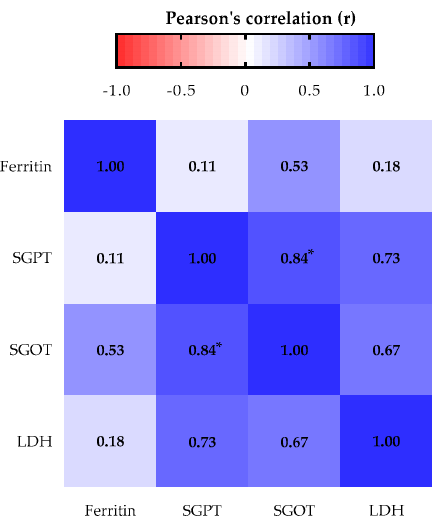
Figure 1. Pearson’s correlation between the levels of liver biomarkers in patients with altered ferritin. Values of r > 0.7 and r < − 0.7 were considered strong positive and negative correlations, respectively. * p < 0.05.